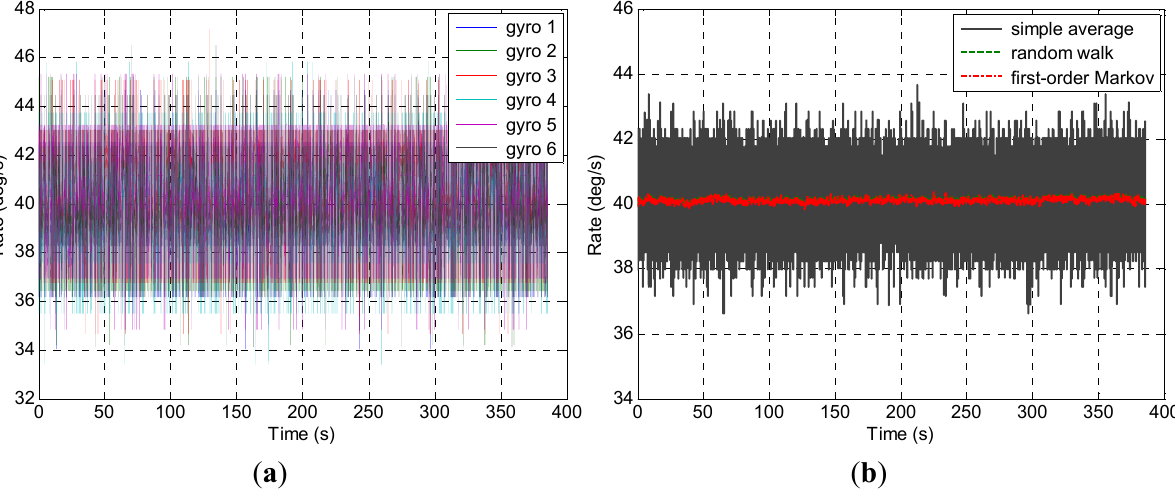
Figure 7. Constant rate test of the virtual gyroscope. ( a ) Outputs of the individual gyroscopes; ( b ) Outputs of the virtual gyroscope.